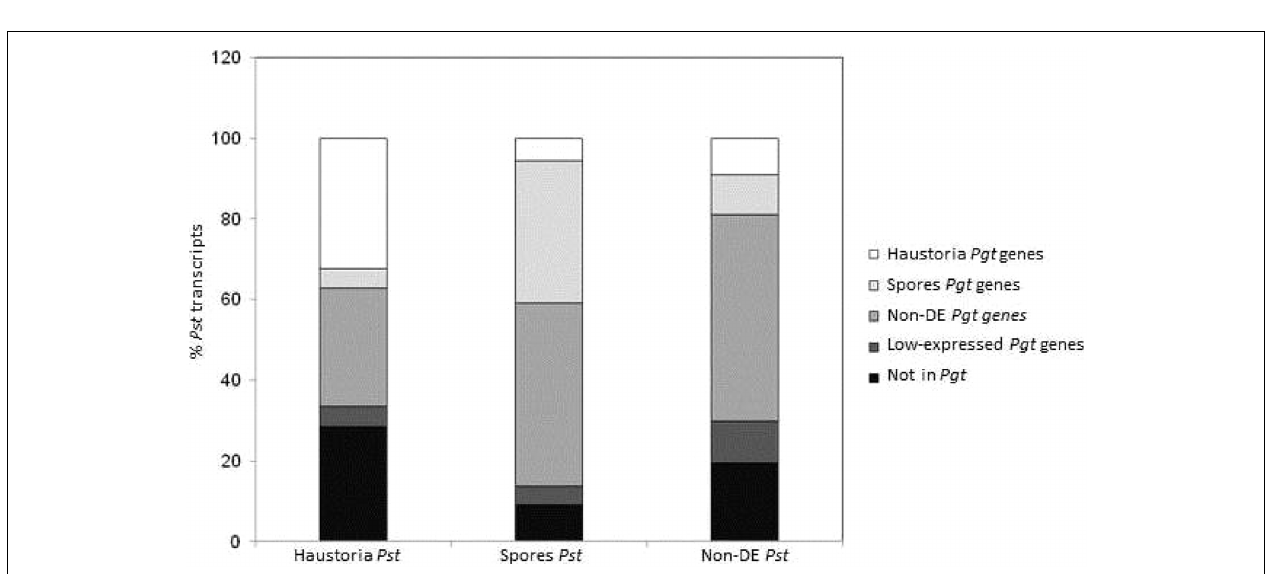
did not show differential expression between the two tissues (Non-DE, 7,936) were BLAST searched (max E-val 1.0e-6) against the Pgt 21-0 predicted gene set.The percentage of transcripts matching genes in the same (or different) expression profile category in Pgt are shown in